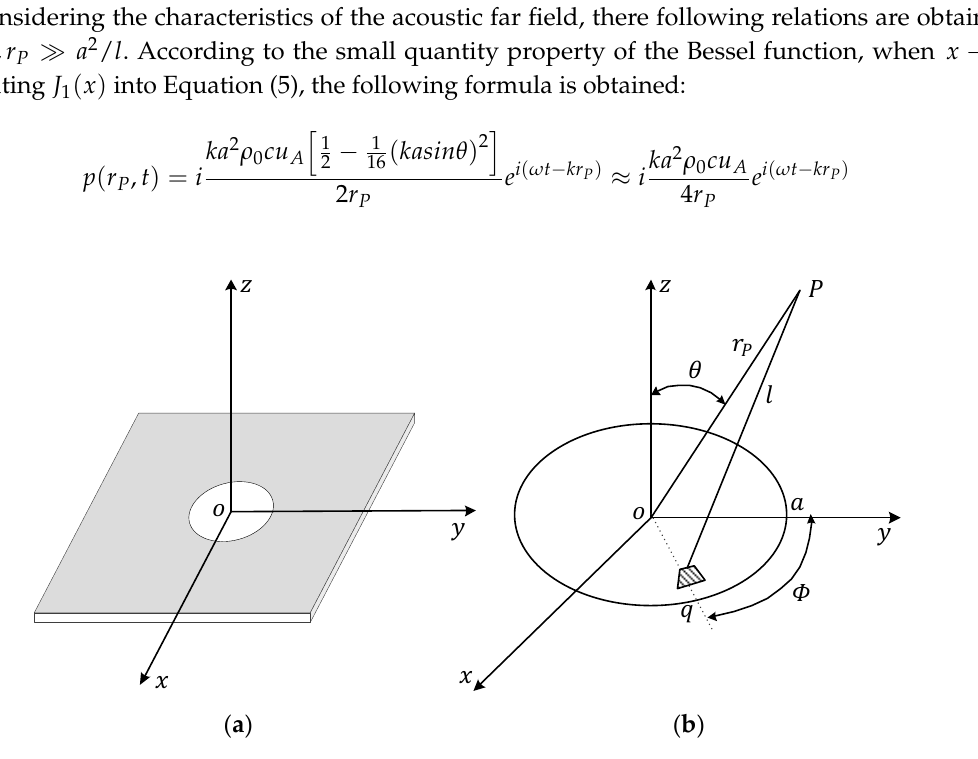
Figure 6. ( a ) Circular piston on infinite baffle; ( b ) radiated acoustic field of circular piston.